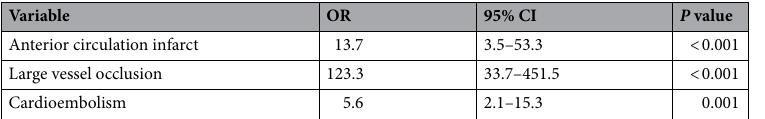
Table 2. Independent factors associated with prominent vessel sign. CI confidence interval; OR odds